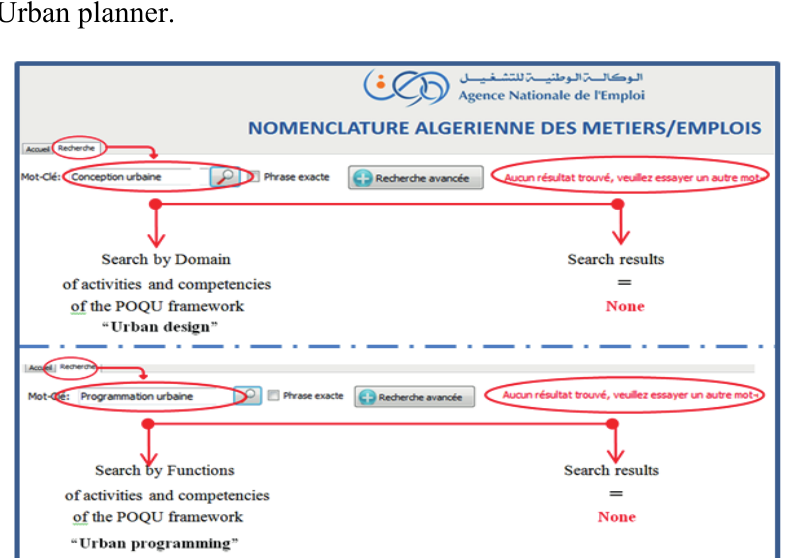
Fig. 2. Search result for the urban planner trade using domains and functions of the POQU